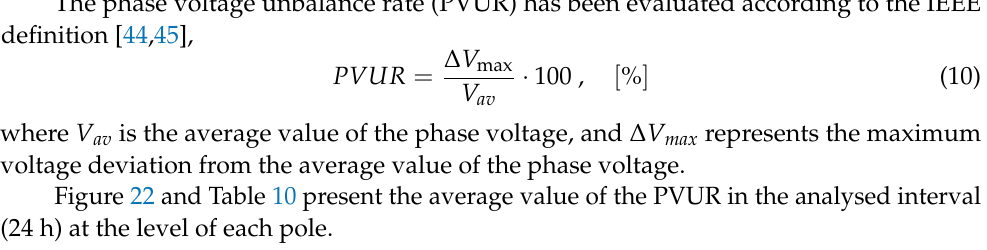
Figure 22 and Table 10 present the average value of the PVUR in the analysed interval (24 h) at the level of each pole.